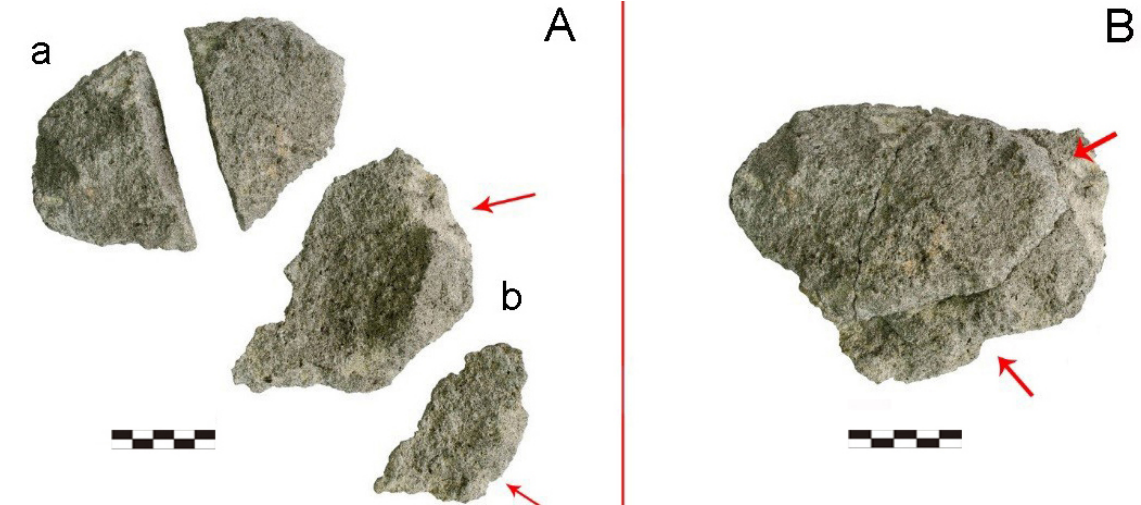
Figure 8. Example of the refitting of vesicular basalt flakes from the fashioning of a rotary quern at the Cardones workshop. A) Fragment: Assemblage of flakes (a. Siret accidental break b. unidirectional flakes), B) result of flakes refitted. The scale bar is 5 cm long (1 cm